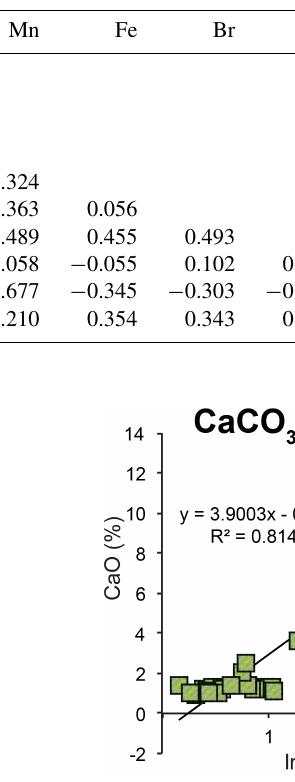
Table 3. R Pearson Linear correlation between XRF-scanner elements.